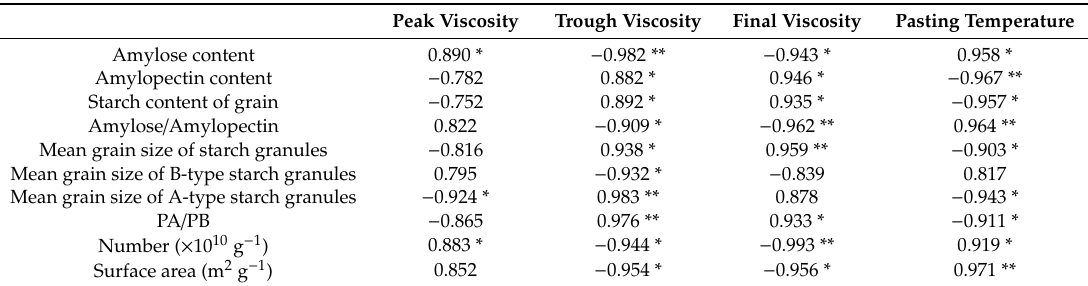
Table 5. Correlation coe ffi cients between starch composition, starch size distribution values and RVA characteristic